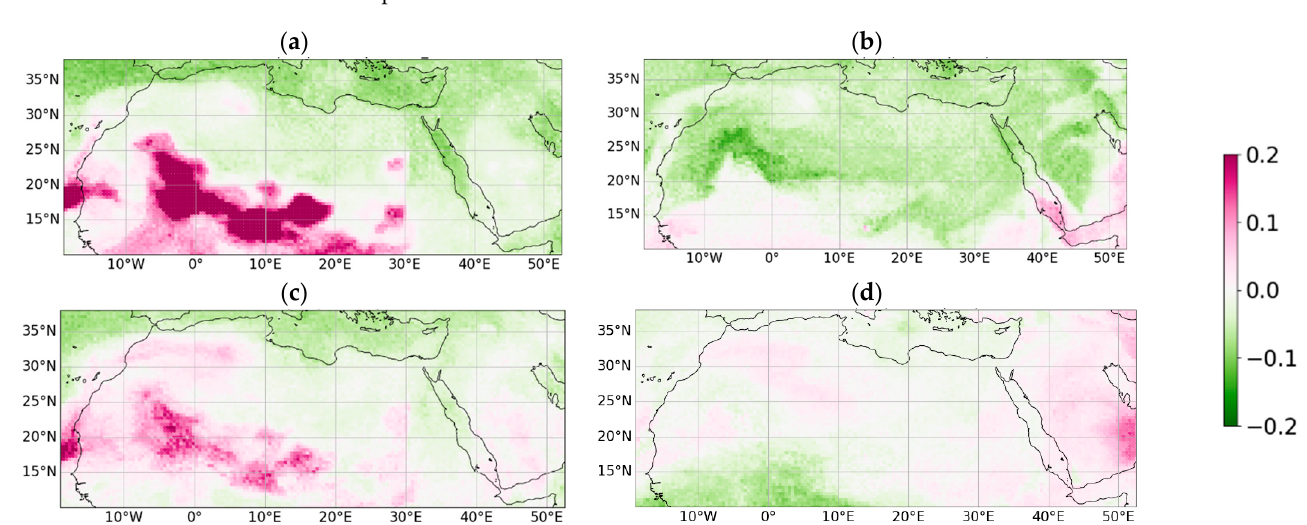
Figure 6. Shapley values for ( a ) raw CHIMERE AOD, ( b ) specific humidity, ( c ) PM 10 , and ( d ) nitrate particles for the RF model for the 30 September 2021.